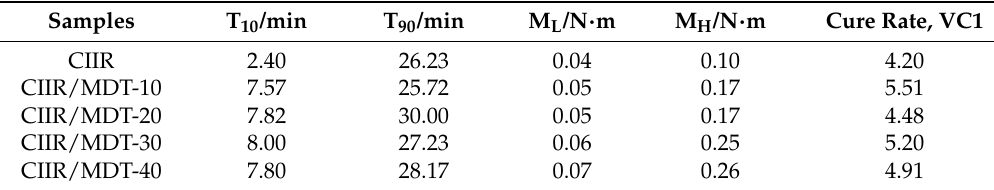
Table 3. Cure data of different CIIR